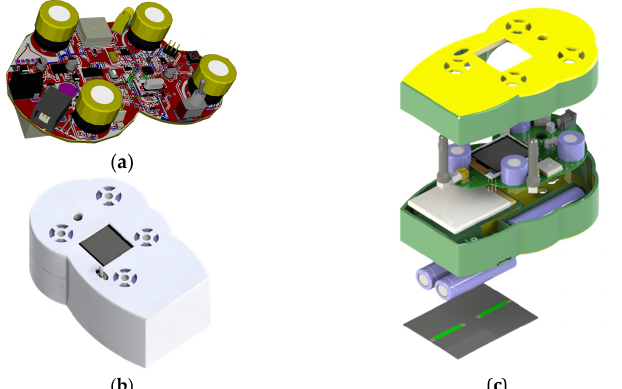
Figure 3. Two 3D Layouts of SeReNo V2 AQM Node: ( a ) Top View; ( b ) Bottom View and ( c ) SeReNo V2 Complete Assembly. Three SeReNo V2 nodes were fabricated and deployed in QU for outdoor testing.